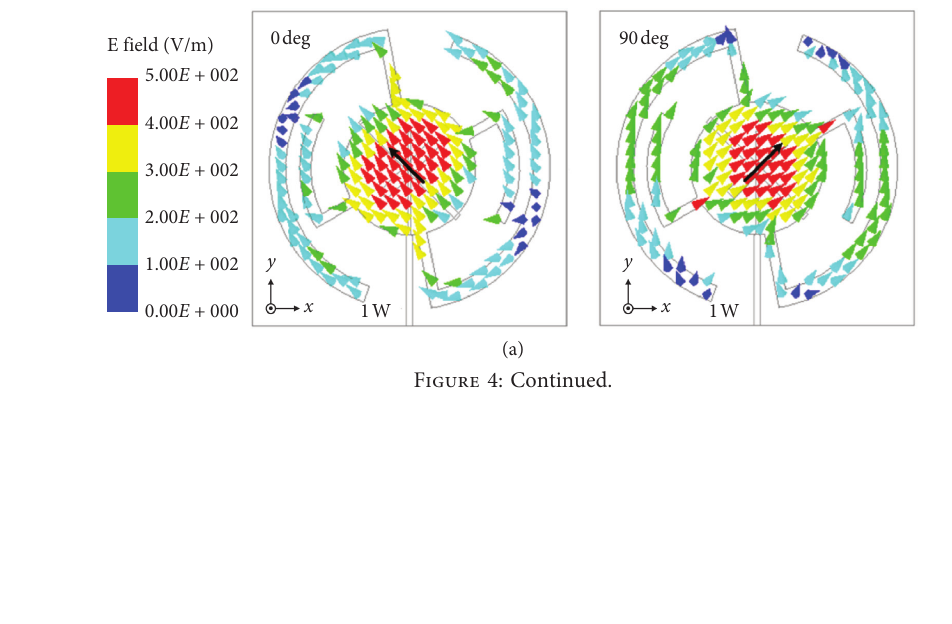
11 | curves and (b) AR curves.